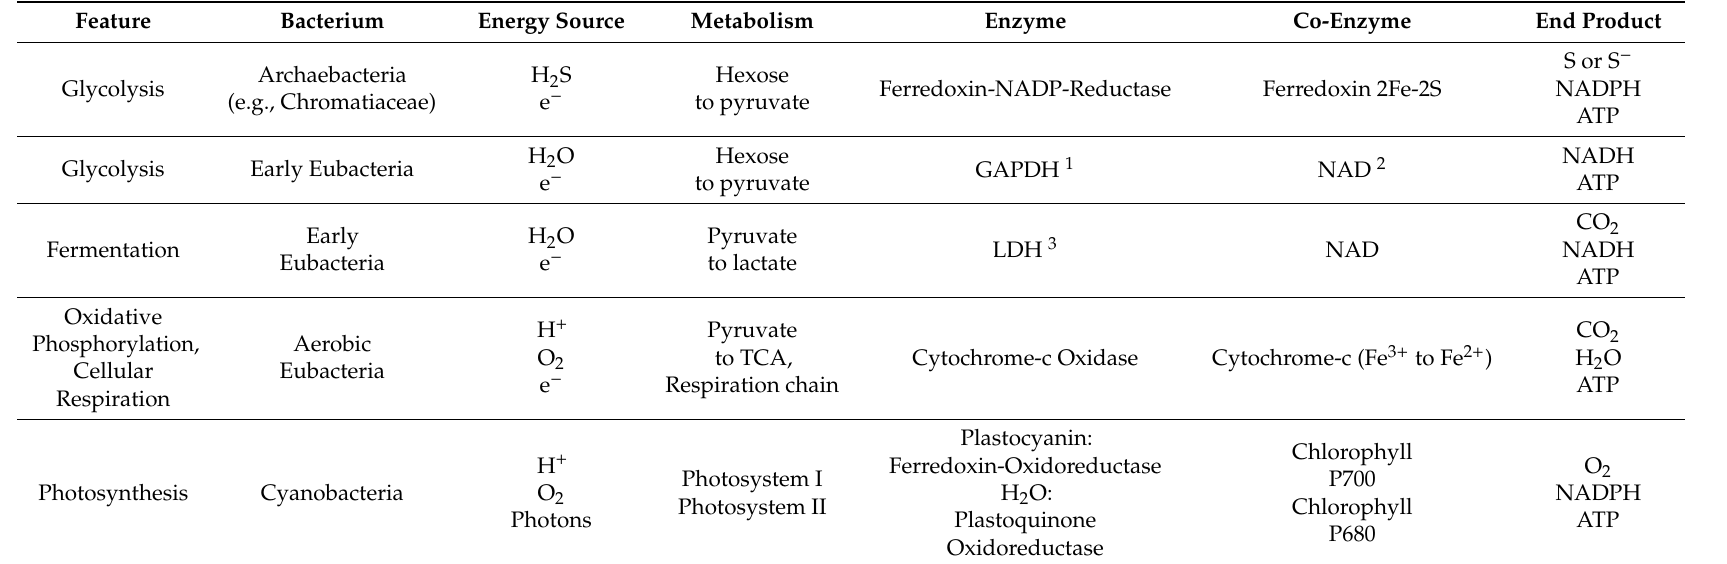
Table 1. Energy production by